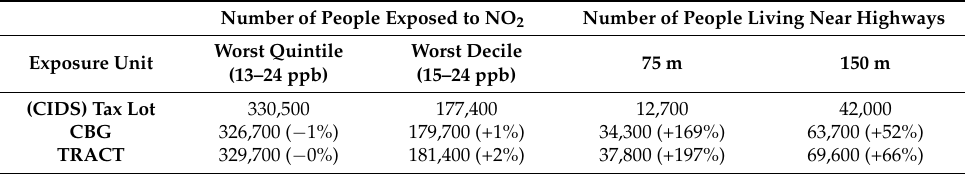
Figure 2. Distribution of the highest concentrations of NO 2 in areas with the greatest number of people. Table 3. Comparison of the total population exposed to degraded air quality using three geographic extents, and two distances from freeways.